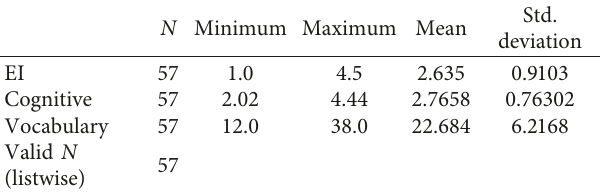
Table 4: Descriptive statistics of the three variables. N Minimum Maximum Mean